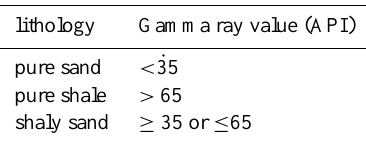
Fig. 1. Location of the Cambay basin and its oil and gas fields (after www.spgindia.org/paper/sopt_2313/tmp_2313). Ankleshwar field is highlighted by the ellipse in the figure. Table 1. Gamma ray values adopted to discriminate pure sand, pure shale and shaly